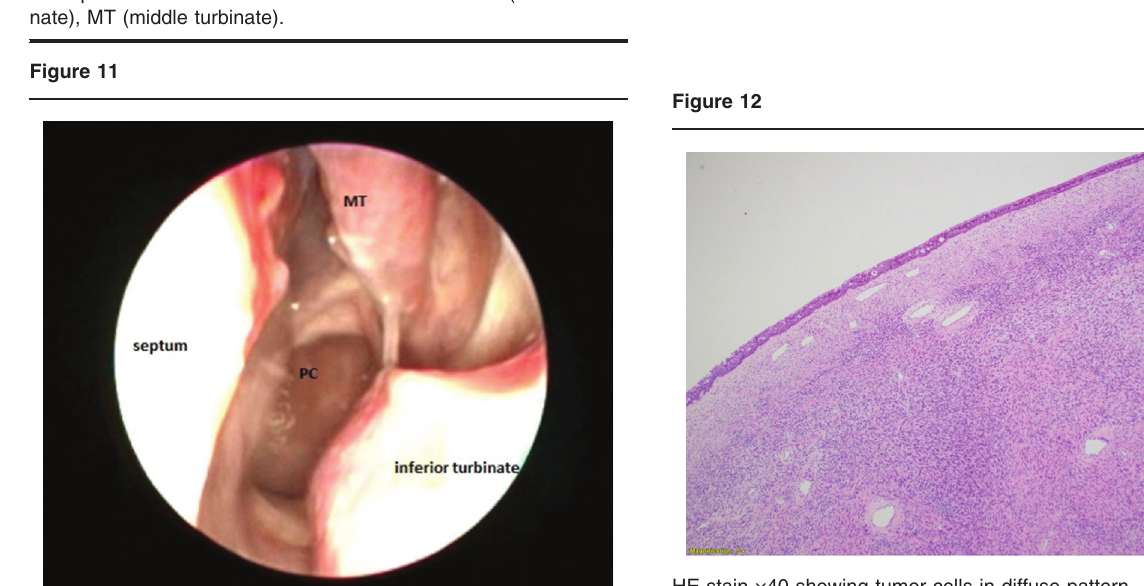
HE stain ×40 showing tumor cells in diffuse pattern.